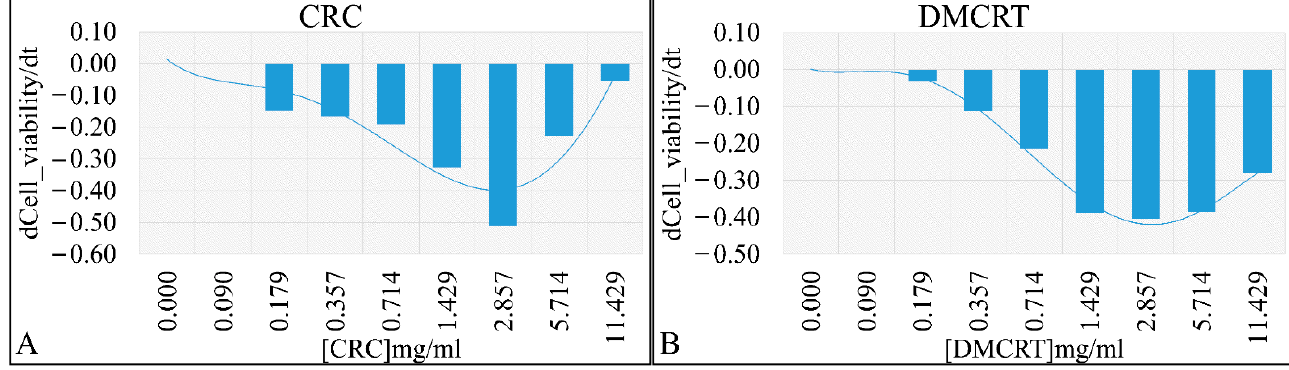
Figure 4. The “speed” by which CRCs and DMCRT reduce cell viability. CRCs manifested a dose- dependent effect from 0–2.857 mg/mL, indicating that the induced “damage” was time dependent. The 5.174 and 11.429 mg/mL concentrations showed that probably all effects were already induced at 24 h and time did not play a role thereafter ( A ). Similarly, DMCRT manifested a dose-dependent increase in “velocity” yet it reached a plateau after 2.857 mg/mL, indicating that its effects were mostly time-dependent in all cases ( B ) ( Legend : CRCs : Crocins, DMCRT : dimethylocrocetin).